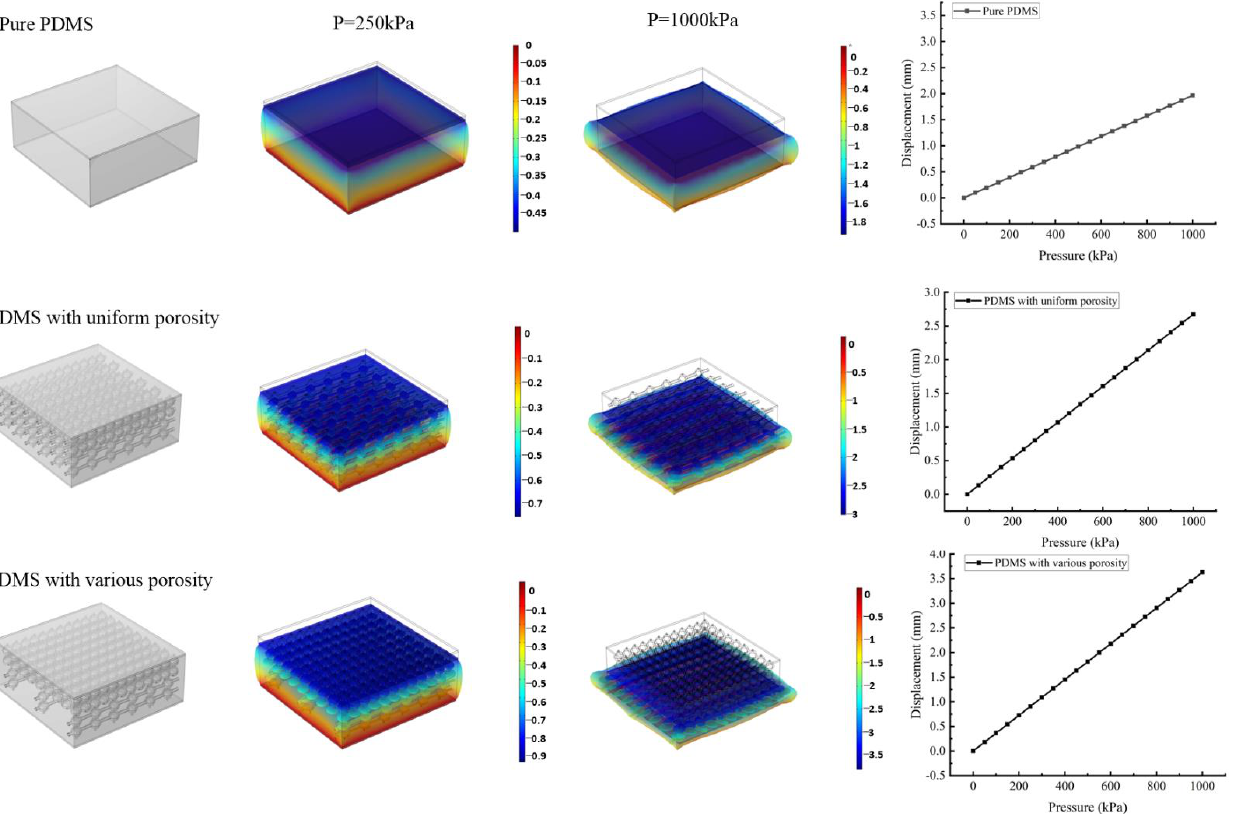
Figure 4. The finite simulation results of dielectrics with different porosity.